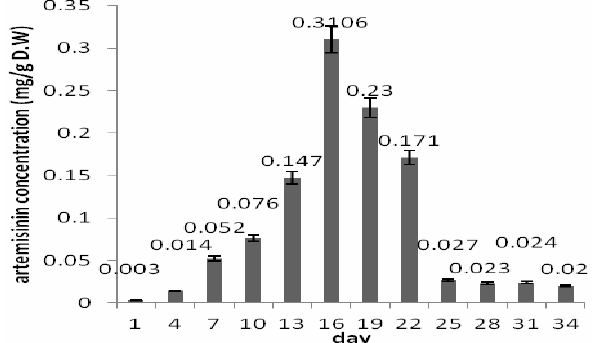
Fig. 13. The artemisinin production by A. annua cells during a month culture